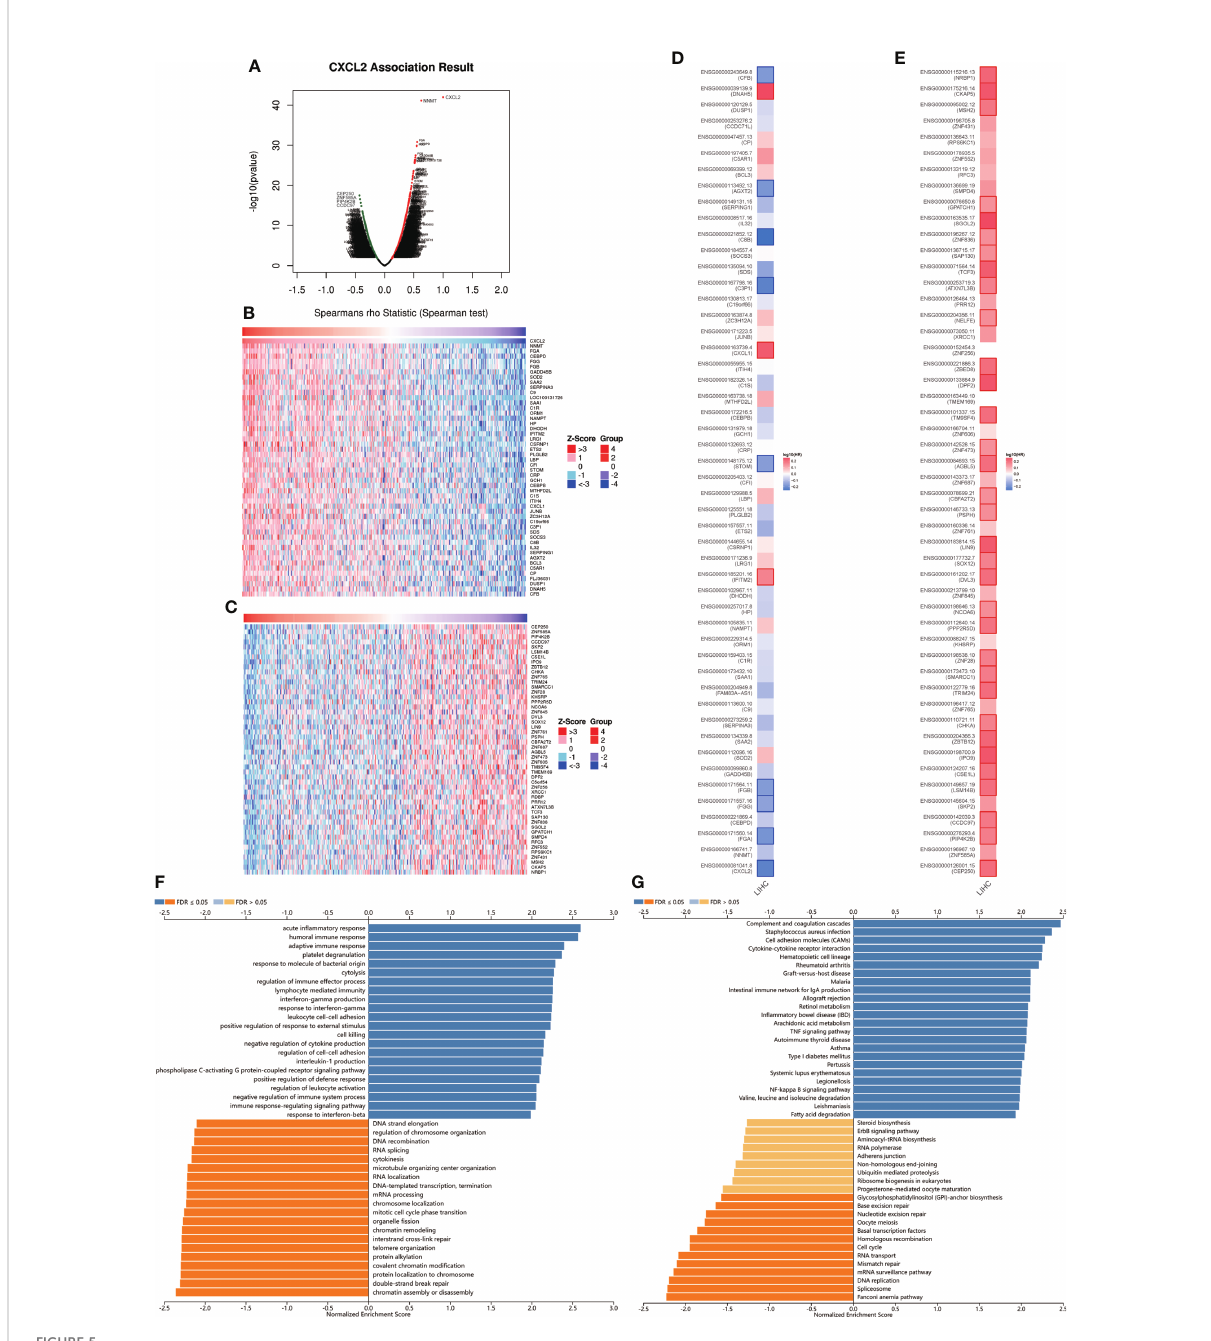
FIGURE 5 The co-expression network of CXCL2 in HCC. (A) Volcano plot for genes positively or negatively associated with CXCL2 in TCGA-LIHC cohort by LinkedOmics database. Red dots represent genes positively correlated with CXCL2, and green dots represent negative correlation (B, C) Heatmaps of the top 50 genes positively and negatively correlated with CXCL2 in HCC, respectively. (D, E) survival maps of the top 50 genes harboring positive and negative correlations with CXCL2 in HCC. (F, G) GO and KEGG pathways of CXCL2-associated network in TCGA-LIHC